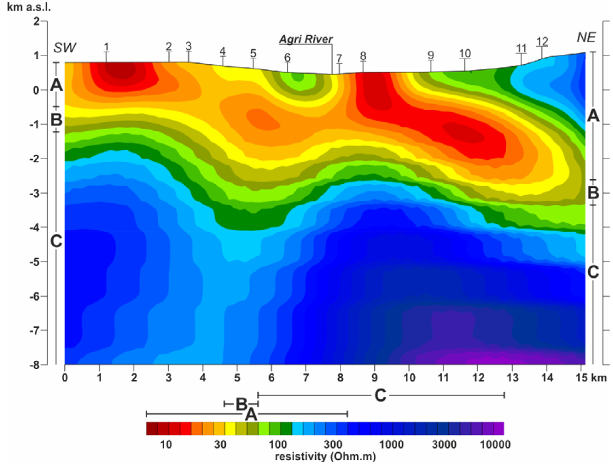
Figure 5. MT resistivity model obtained by joint inversion of TE and TM modes. A, B and C define the variability range of resistivity of the main features well-rendered in the